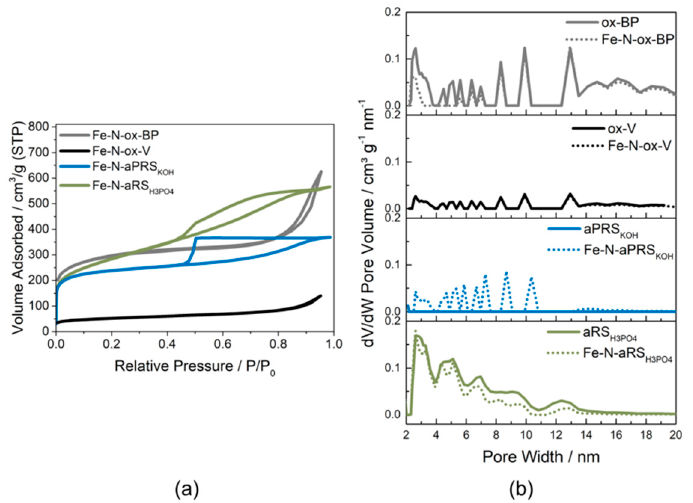
Figure 8. ( a ) Nitrogen sorption isotherms of Fe-N-C materials and ( b ) pore size distribution of carbon supports and Fe-N-C materials.